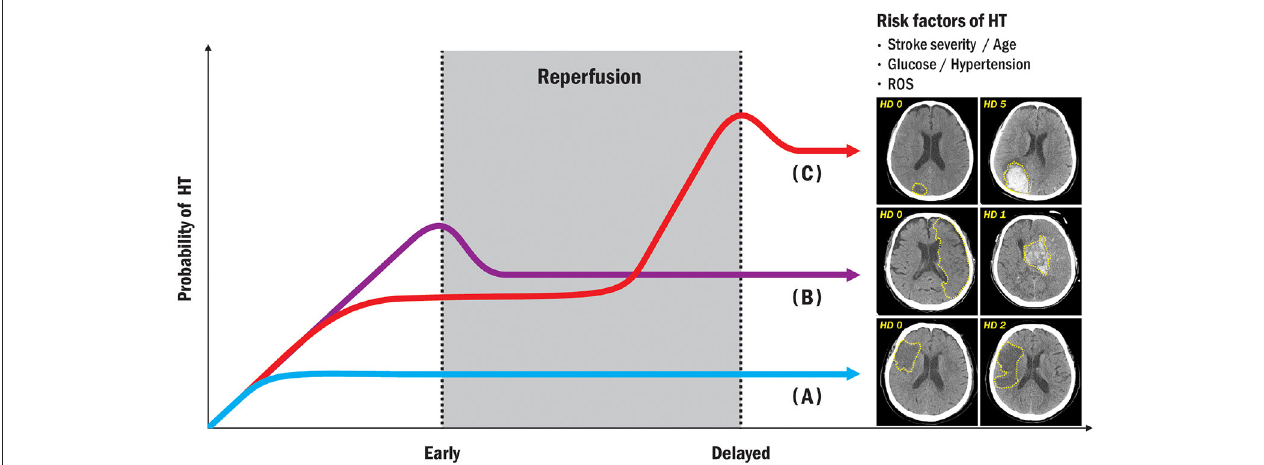
FIGURE 1 | Illustration showing correlation between HT and reperfusion time after ischemic stroke. Under the risk factors commonly associated with HT; (A) no HT (no bleeding regardless of reperfusion); (B) early HT (definite bleeding usually 6–24h after stroke); (C) delayed HT (definite bleeding usually more than 24h after ischemic stroke). HT, hemorrhagic transformation; ROS, reactive oxygen